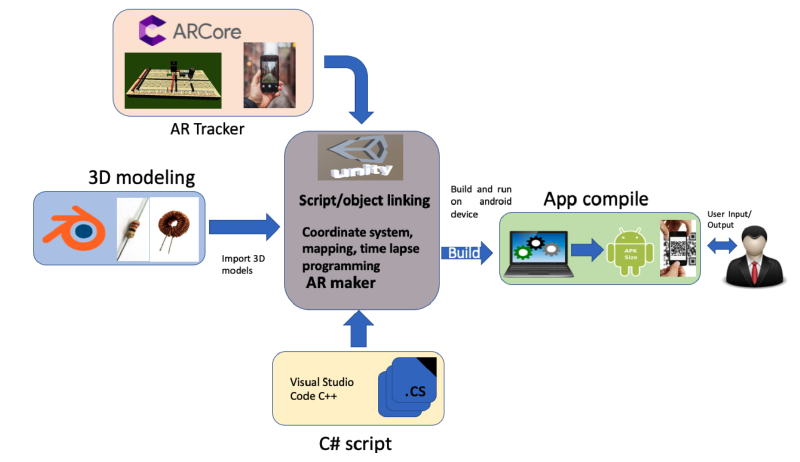
Figure 2. Designing the AR—electronics app in